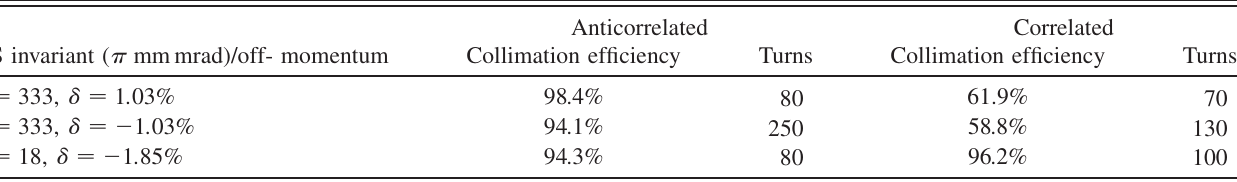
TABLE IV. Collimation efficiencies and turns to collimate all the particles hitting the primary momentum collimator with the combined collimation method at the energy of 80 MeV, with the transverse collimation efficiency taken as 100%. C-S invariant ( (cid:4) mm mrad )/off-